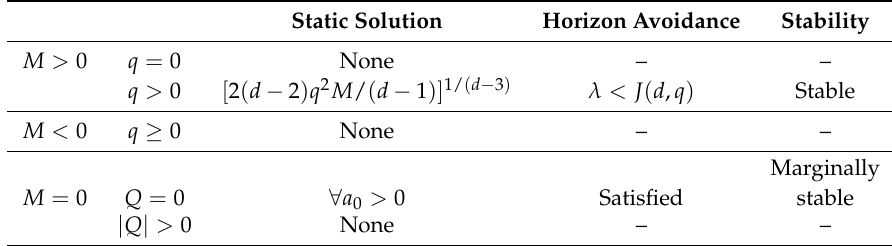
Table 3. The existence and stability of static wormholes in planar symmetry in four and higher